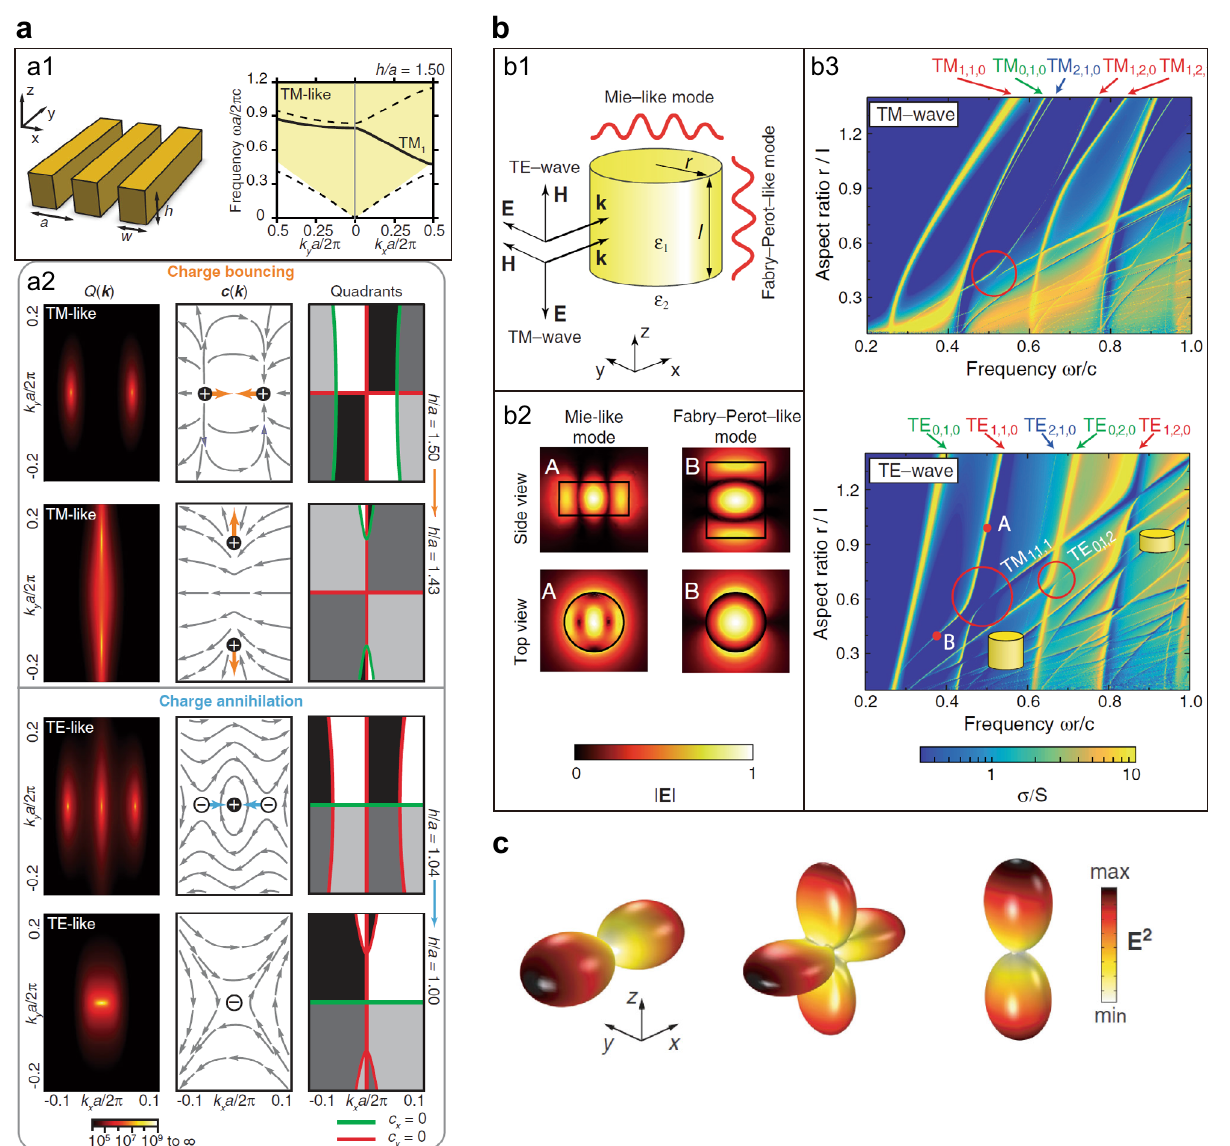
Fig. 4 Understanding physical mechanism of BICs. a Evolution of BICs and conservation of topological charges. Schematic of a 1D periodic structure and its calculated TM-like band structure (a1). The bouncing behavior of the two positive topological charges in TM-like band (charge bouncing) and the annihilation behavior of one positive and two negative topological charges in TE-like band (charge annihilation) (a2). The conservation law for the total topological charges predicts the behaviors of BICs with a system variation. Reprinted by permission from ref. 38 , copyright 2014. b Strong coupling of modes in a dielectric resonator. Schematic of a dielectric cylindrical nanoresonator (b1) and calculated fi eld pro fi les for the Mie-like mode and Fabry-Pérot- like mode (b2). Avoided resonance crossing (red circles) in the calculated graphs of the aspect ratio of the nanocylinder vs. frequency, for TM and TE- polarized incident waves (b3). c Far- fi eld radiation patterns of TM 1,1,1 mode in the nanocylinder in ( b ) for different aspect ratios. The middle image corresponds to the quasi-BIC. Reprinted by permission from ref. 41 , copyright